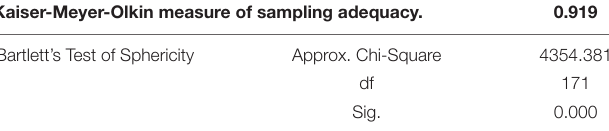
TABLE 2 | KMO and Bartlett’s test.